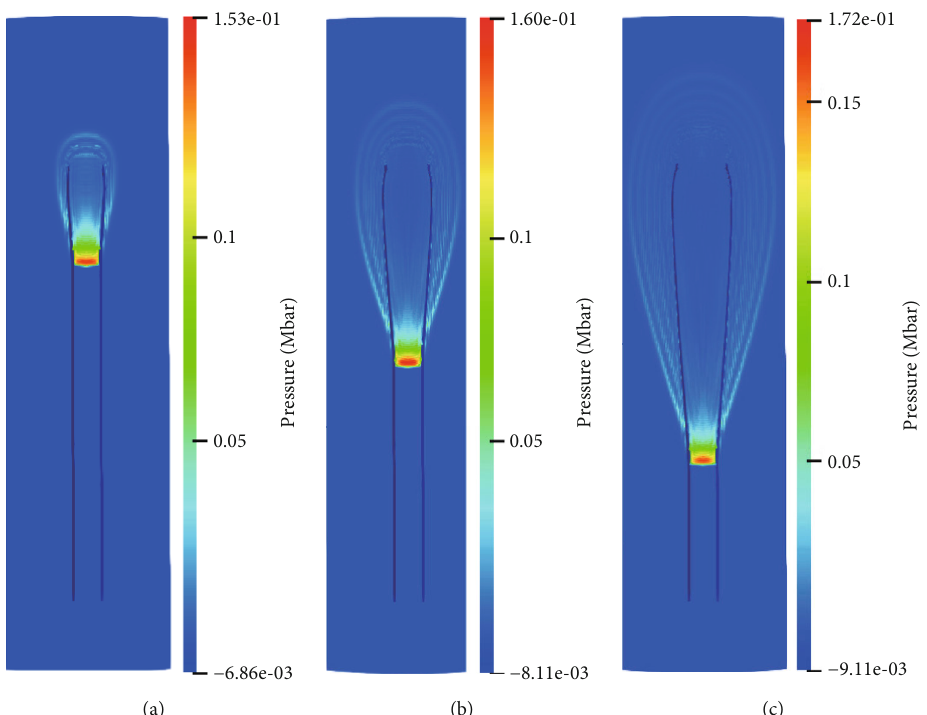
Figure 10: The pressure contour for cylinder test in water medium by CFEMP scheme: (a) t = 10 μ s, (b) t = 20 μ s, and (c) t = 30 μ